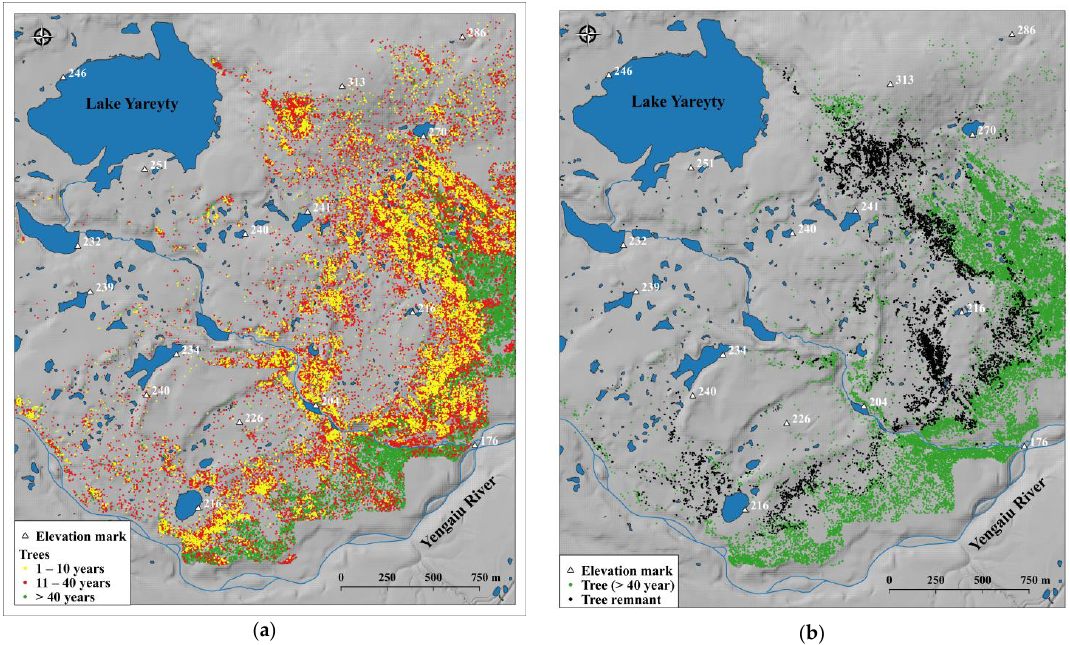
Figure 5. Map of Siberian larch tree distribution into three age categories: 1–10, 11–40, and 40+ years ( a ), and the location of trees that were previously growing in the region and died during the Little Ice Age, and trees more than 40 years of age ( b ).